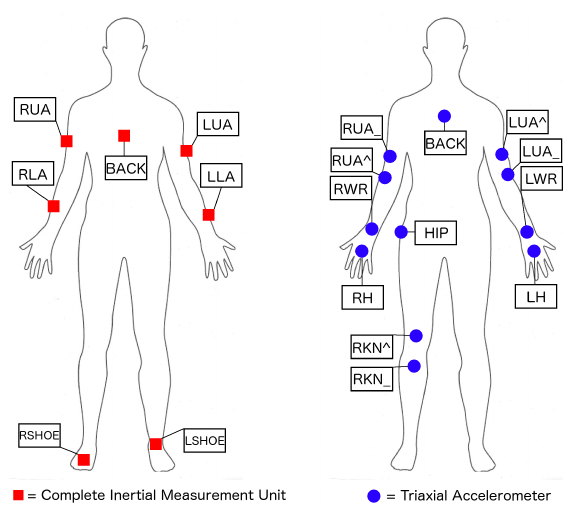
Figure 4. Placement of on-body sensors used in the OPPORTUNITYdataset (left: inertial measurements units; right: 3-axis accelerometers) [7].